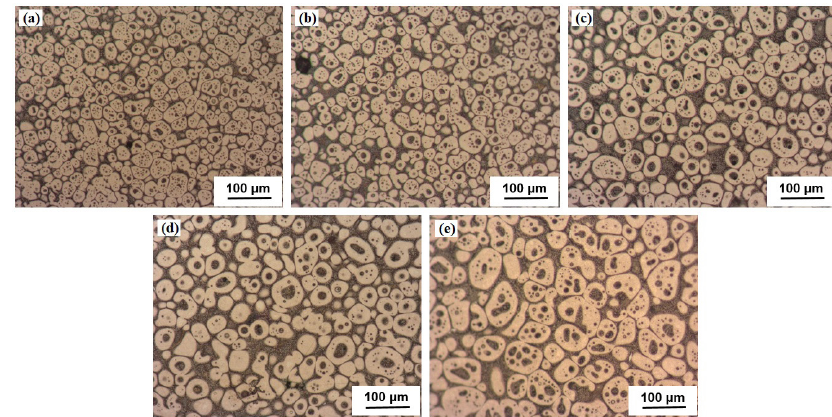
Figure 9. Evolution of phases and species distribution of pure ZA27 alloys thermally treated at 460 ºC at different time: (a) 15 min, (b) 20 min, (c) 30 min, (d) 45 min and (e) 60 min.